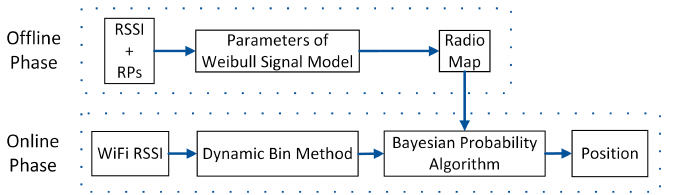
Figure 7. The architecture of the employed fingerprinting-based WiFi algorithm